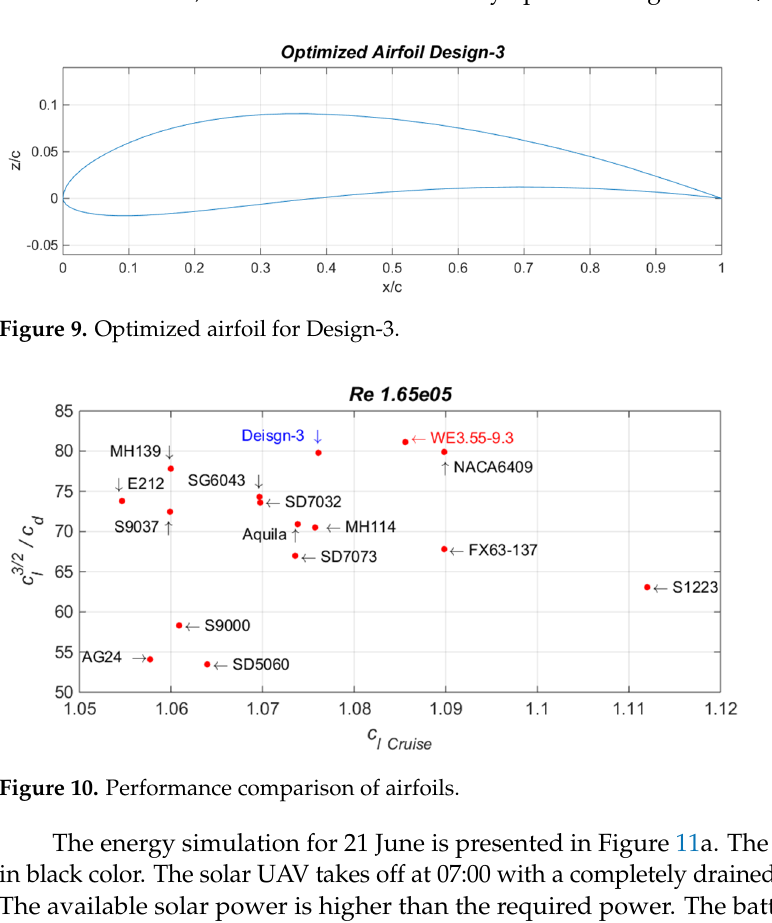
Figure 9. Optimized airfoil for Design-3.